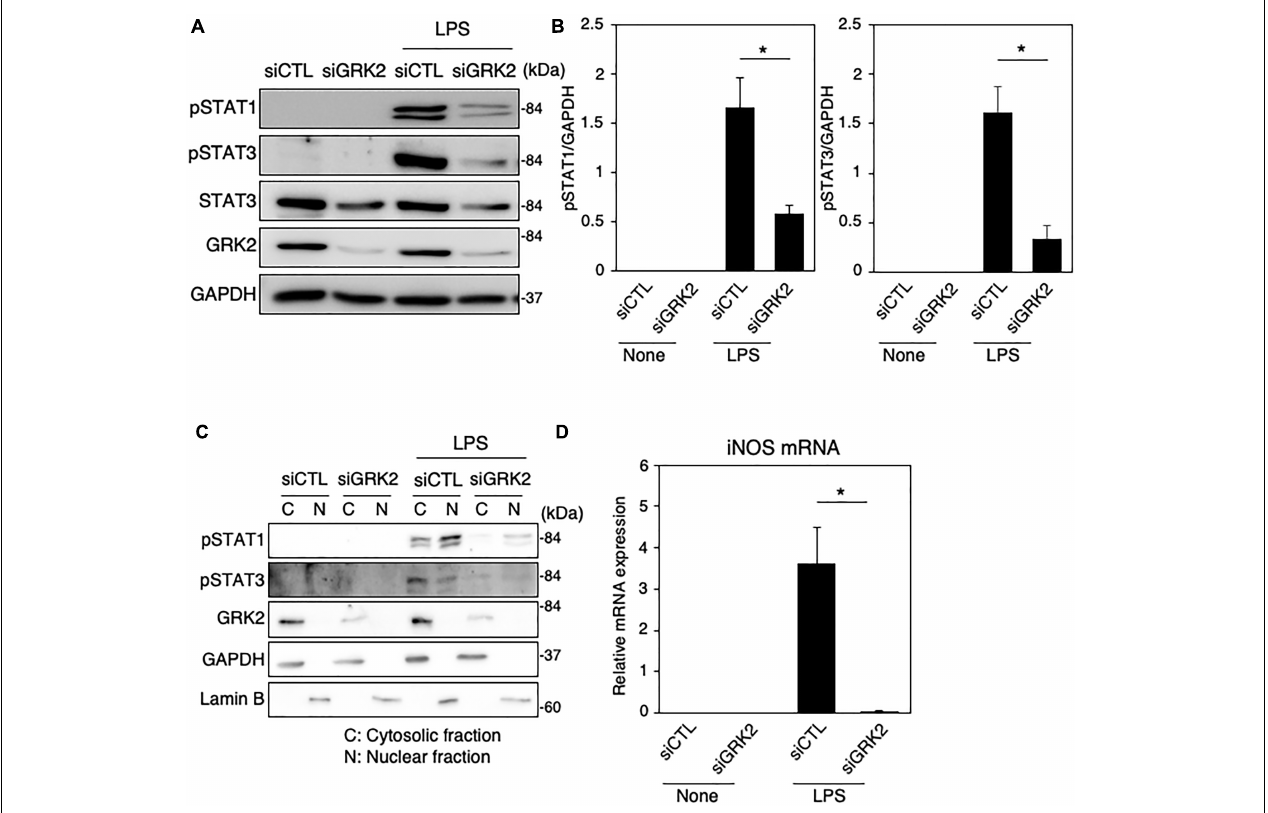
FIGURE 3 | Effect of GRK2 siRNA transfection on total and phosphorylation levels of STAT1 and STAT3 in LPS-stimulated MG6 cells. (A) Typical Western blots of phospho-STAT1 at Tyr-701, phospho-STAT3 at Tyr-705, and total STAT3 before and 6 h after 100 ng/ml LPS application in the presence of GRK2 siRNAs (siGRK2) or the negative control siRNAs (siCTL). Transfection of siGRK2, but not of siCTL, effectively decreased GRK2 protein expression, and GAPDH was used as loading control. (B) Phosphorylated levels of STAT1 and STAT3 6 h after 100 ng/ml LPS application when siCTL or siGRK2 was transfected. (C) Cytoplasmic (C) and nuclear (N) fractions were isolated, and then phospho-STAT1 and phospho-STAT3 6 h after 100 ng/ml LPS were detected by Western blot analysis. GAPDH and lamin B served as a cytoplasmic and a nuclear marker, respectively. Shown are representative Western blots from three independent experiments in which the same results were obtained. (D) Effect of siGRK2 transfection on expression of iNOS mRNA 12 h after 100 ng/ml LPS application. The mRNA levels were expressed as a fold increase above control normalized GAPDH. The results represent the mean ± SEM for three independent experiments. ∗ P < 0.05 by t -test.